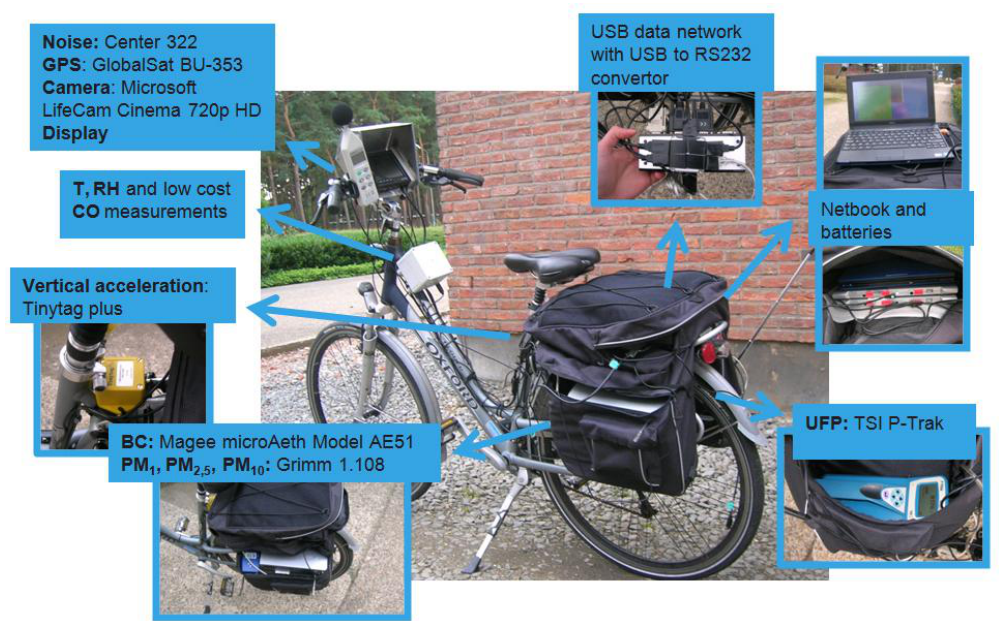
Figure 1. The Aeroflex and its measurement